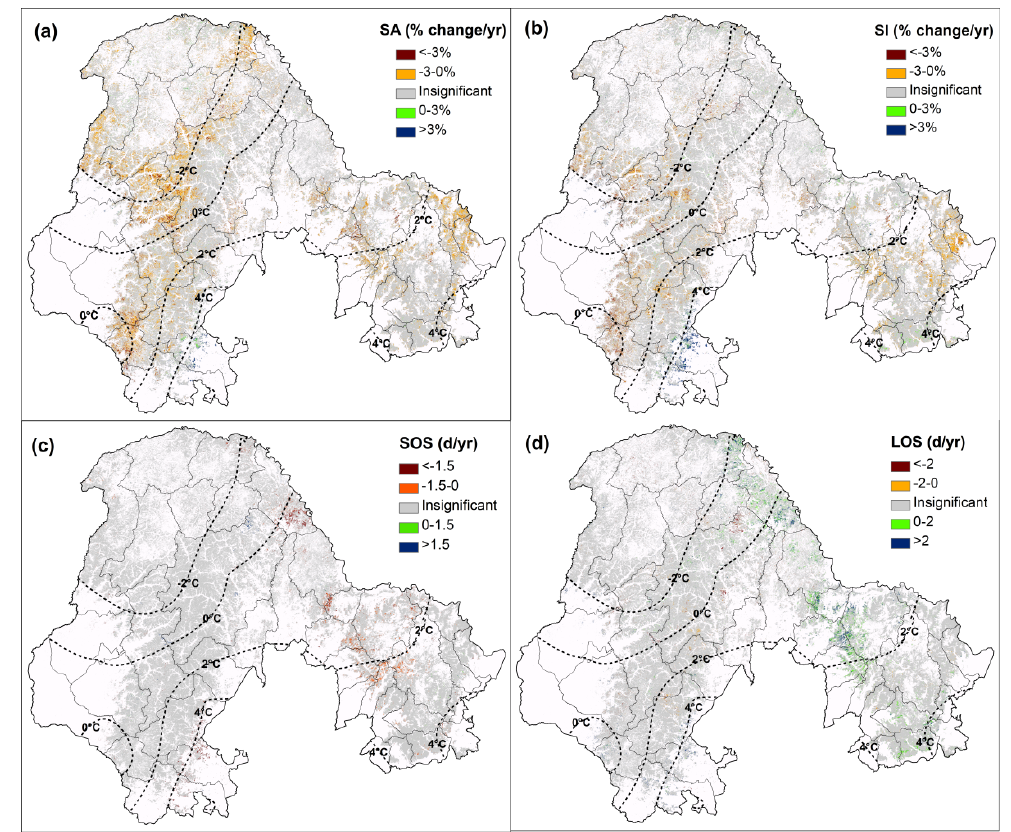
Figure 2. Significant trends in ( a ) SA, ( b ) SI, ( c ) SOS, ( d ) LOS for DBF in the Khingan Mountains. The trends described here were statistically significant at the 95% confidence